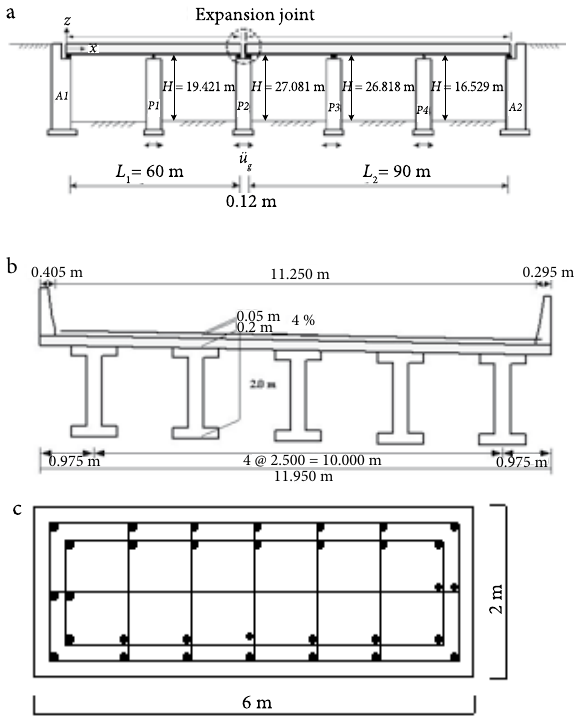
Fig. 4. Longitudinal section (a), cross-sectional view (b) and steel reinforcements of piers (c) of sectional view of the selected bridge